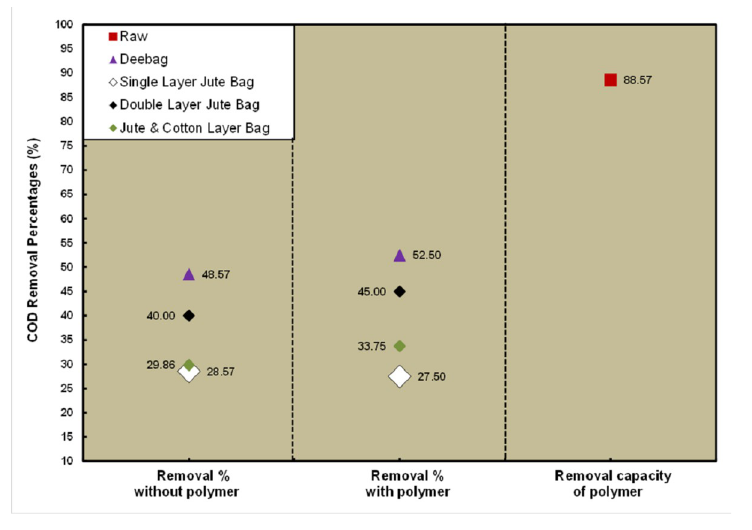
Fig 2. Removal percentages of COD.